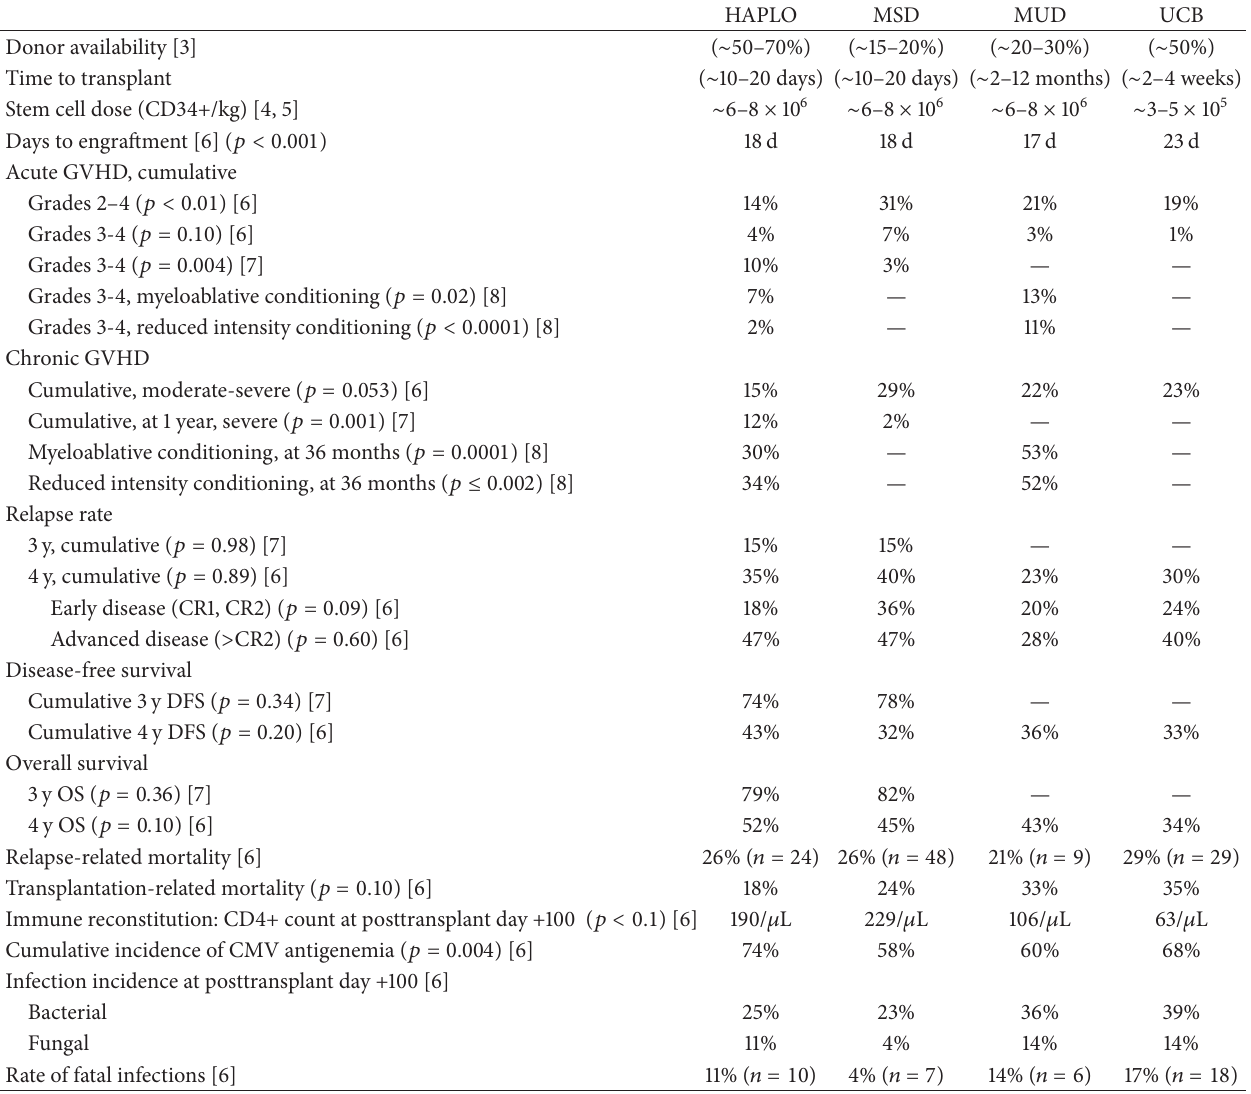
Table 1: Comparative summary of haploidentical (HAPLO) versus matched sibling donor (MSD), matched-unrelated donor (MUD),